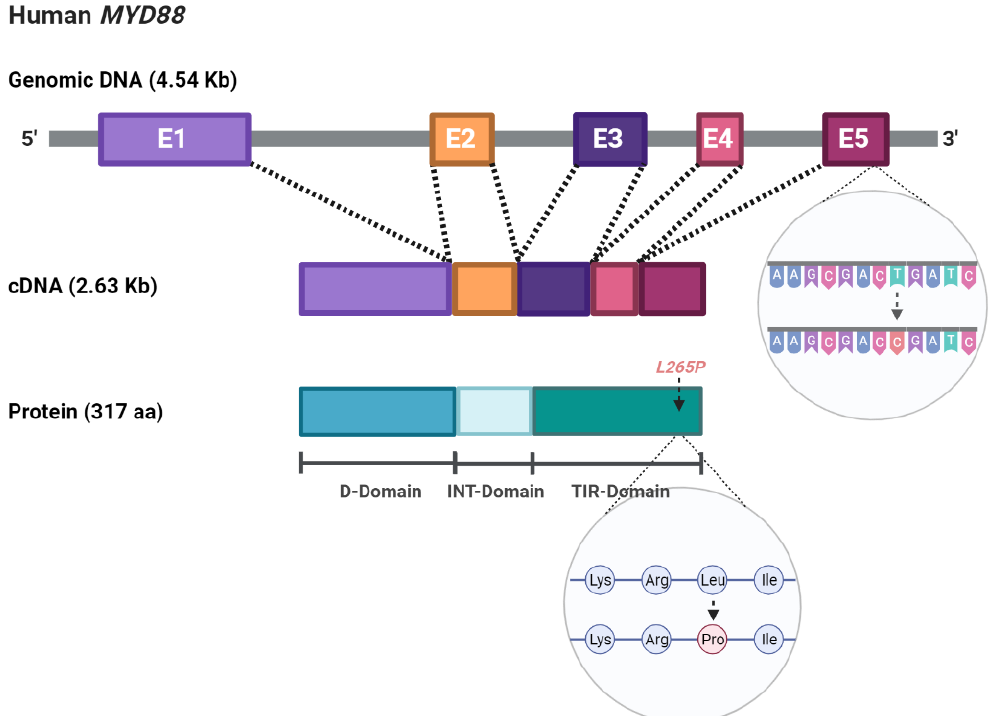
Figure 1. Schematic representation of the MYD88 gene structure and the L265P mutation at the DNA and protein levels.